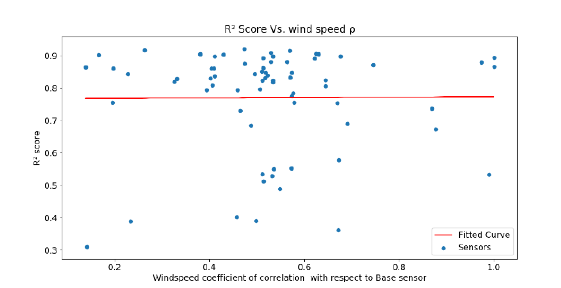
Figure 16. Wind direction Correlation and R 2 Score